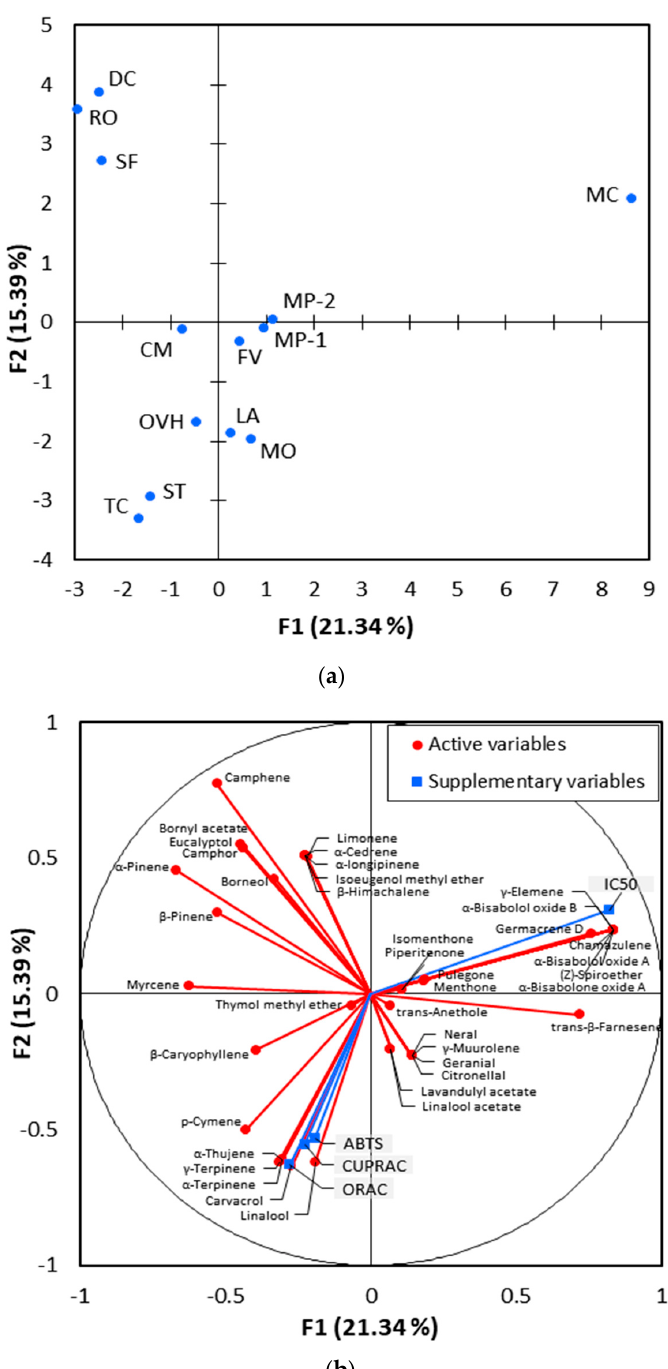
Figure 2. Principal Component Analysis ( a ) scores plot and ( b ) loadings plot obtained from the compositional data of the essential oils under investigation (active variables; red vectors). The anti-bacterial activity (denoted as IC 50 ) and the antioxidant capacity determined by CUPRAC, ABTS and ORAC methods are also projected on the loading plot (blue vectors; supplementary variables).